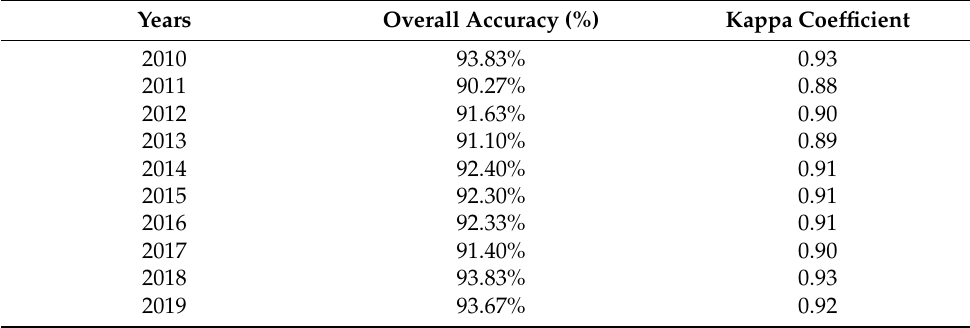
Table 4. Accuracy assessment of multi-temporal classification maps.